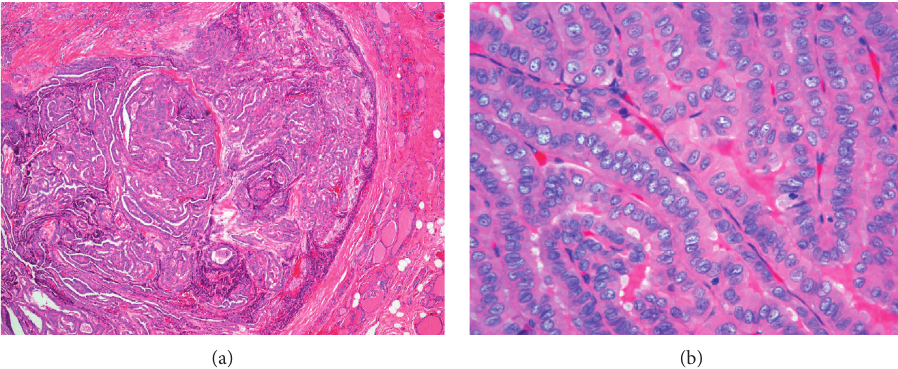
Figure 2: Pathology of the resected soft tissue of the neck showing (a) the presence of papillary thyroid carcinoma in the background of necrotic tissue (H&E, 20x). Pathology of the cervical lymph node showing (b) the presence of metastatic papillary thyroid carcinoma tumor (H&E, 400x).